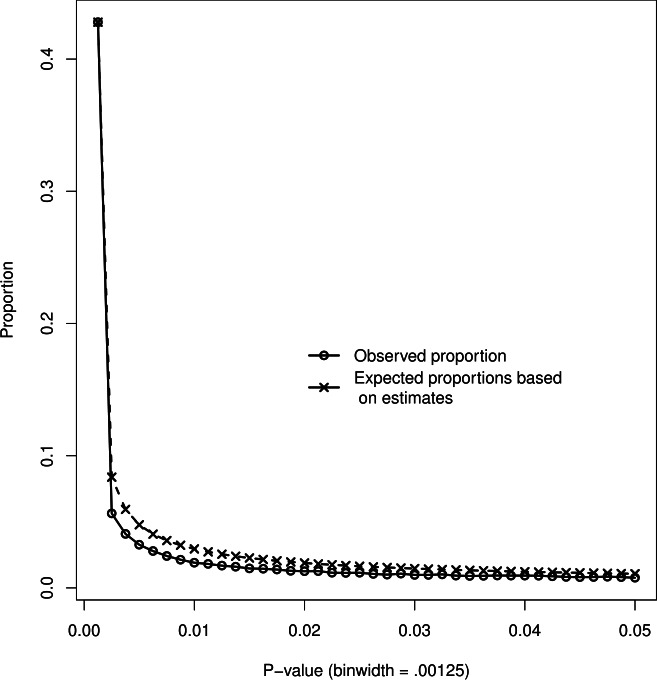
Observed proportions of p-values (circles) and expected proportions of p-values based on \documentclass[12pt]{minimal}
\usepackage{amsmath}
\usepackage{wasysym}
\usepackage{amsfonts}
\usepackage{amssymb}
\usepackage{amsbsy}
\usepackage{upgreek}
\usepackage{mathrsfs}
\setlength{\oddsidemargin}{-69pt}
\begin{document}
}{}${\hat {\rho }}_{F}$\end{document}ρ ˆF and \documentclass[12pt]{minimal}
\usepackage{amsmath}
\usepackage{wasysym}
\usepackage{amsfonts}
\usepackage{amssymb}
\usepackage{amsbsy}
\usepackage{upgreek}
\usepackage{mathrsfs}
\setlength{\oddsidemargin}{-69pt}
\begin{document}
}{}${\hat {\tau }}_{{\rho }_{F}}$\end{document}τ ˆρF estimated from 0–.00125 (crosses).